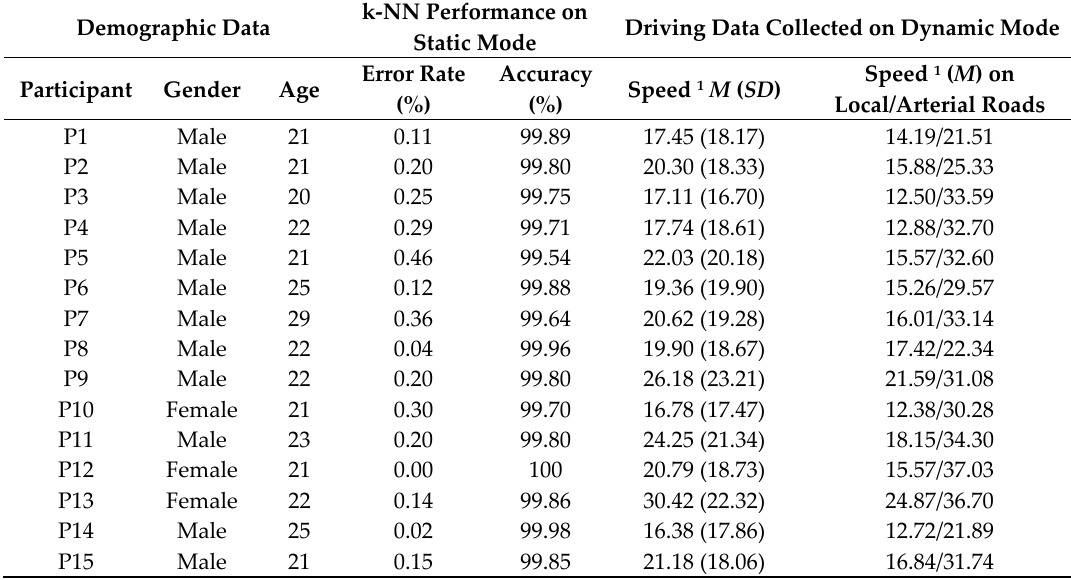
Table 1. Participant characteristics.